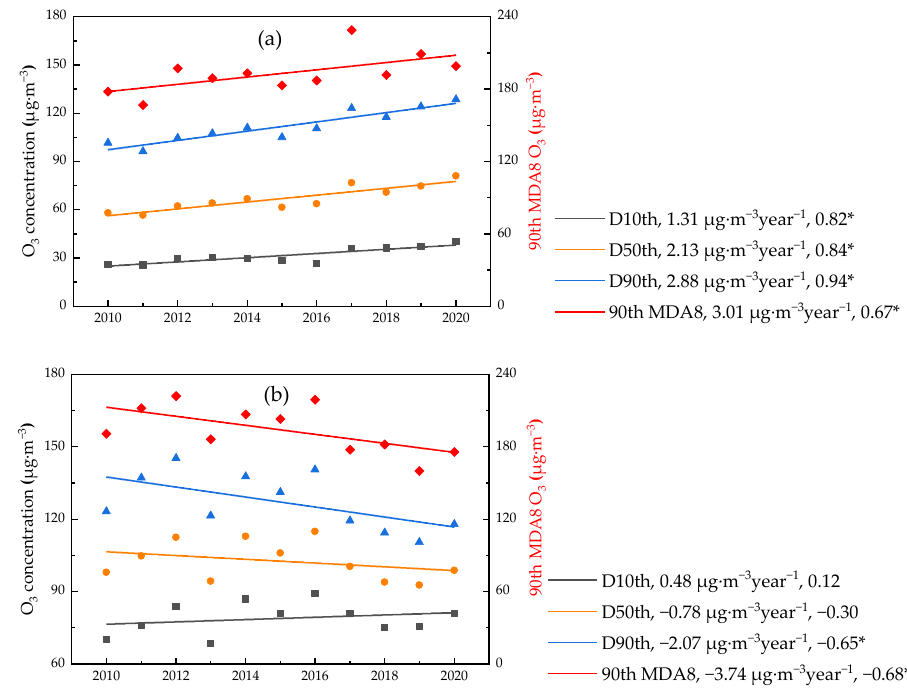
Figure 2. Mean values of daily 10th percentile, 50th percentile, and 90th percentile ozone concentrations (abbreviated as D10th, D50th, and D90th) and the trends of 90th percentile MDA8 (90th MDA8) per year in Jinan from 2010 to 2020. Figure ( a ) shows the urban area (SZ), and Figure ( b ) shows the suburban area (PML). Solid line: linear fit curve. Inset: Linear trend and Spearman′s order correlation coefficient. Note: * indicates that the requirement of significance was reached ( p < 0.05). The 90th MDA8 O 3 corresponds to the right axis and the D10th, D50th, and D90th O 3 to the left axis.